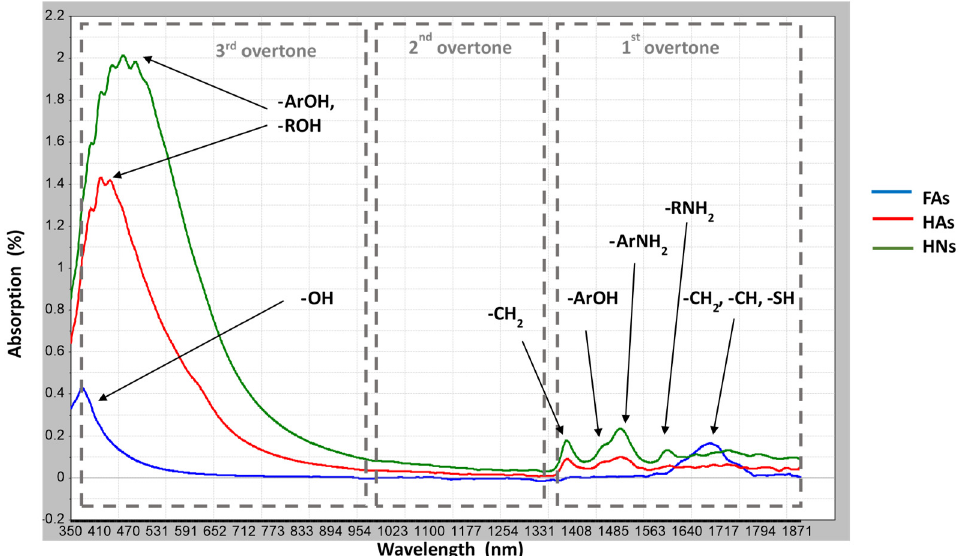
Figure 2. Mean VIS-NIR spectra of isolated FAs, HAs, HNs (n = 30) obtained by the Ward’s Figure 2. Mean VIS - NIR spectra of isolated FAs, HAs, HNs (n = 30) obtained by the Ward’s method. The obtained mean spectra for the three HS fractions differed significantly (Figure 2). HNs show higher absorptions, as compared to HAs and FAs in all the spectra ranges. This is probably related to the broad absorption bands that are dominated by chromophores and are also caused by the darkness of the HNs.